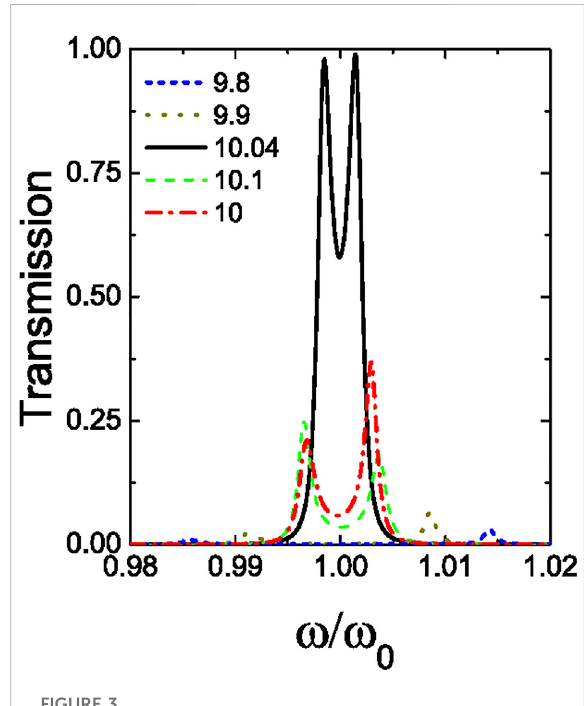
FIGURE 3 Transmissionspectraaroundthethicknessgradientforwhich the Zener-like resonant effect occurs (same acoustic multilayer as in Figure 1). The transmission is plotted for several gradients (in %) as a function of the reduced frequency, ω / ω 0 , with ω 0 the central frequency at each